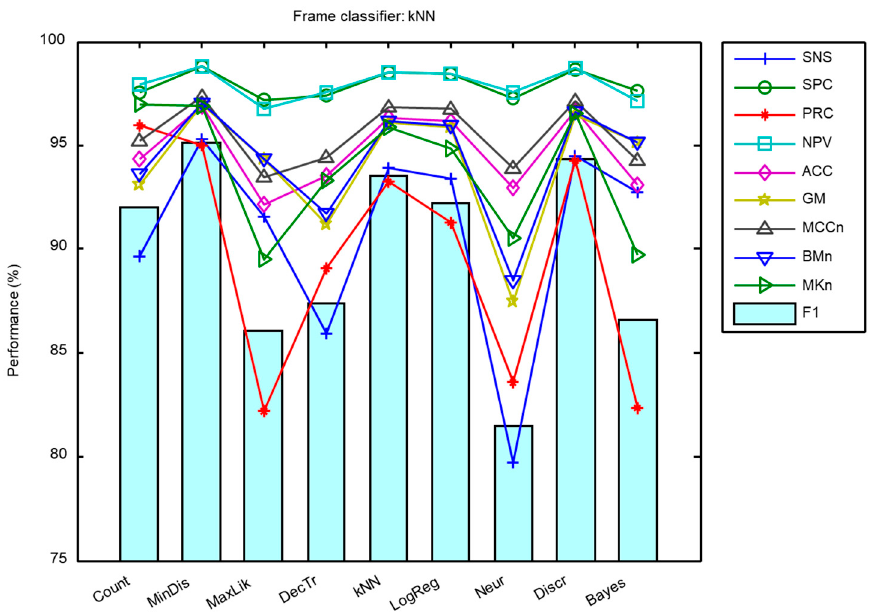
Figure 13. Performance metrics classifying the score series obtained by the kNN frame classifier.